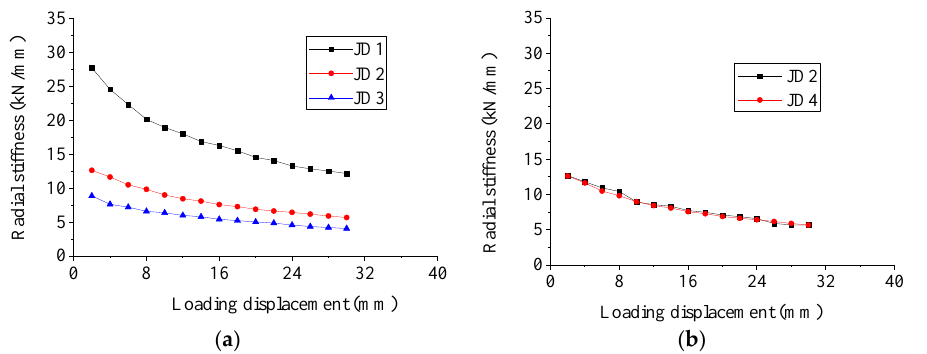
Figure 13. Loading displacement–radial stiffness curve of semi-fixed dowel joint. ( a ) Wall thickness of rubber sleeve. ( b ) Thickness of rubber pad.